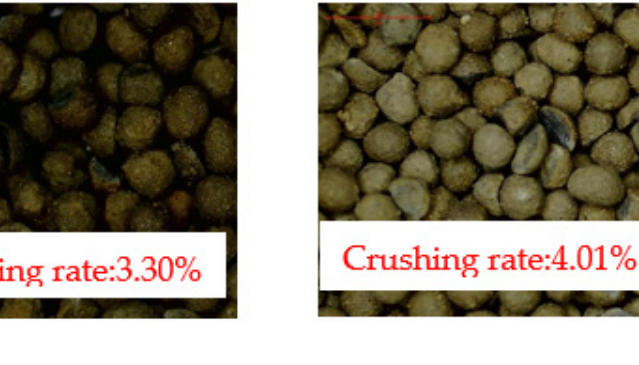
Table 2. Conductivity damage response surface factor level table.